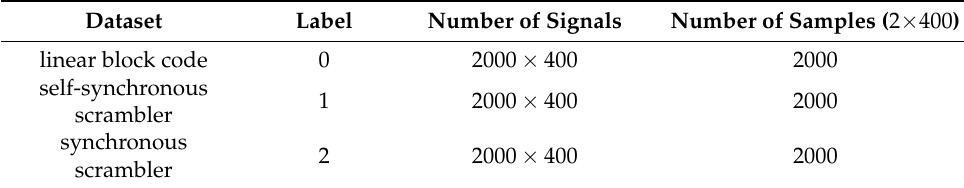
Table 1. Linear block code scrambling dataset under bit error.